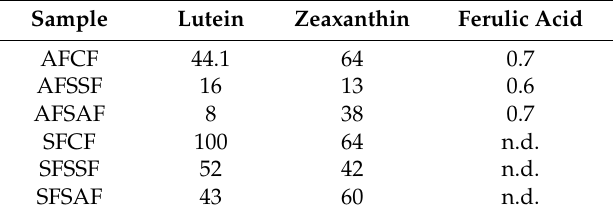
Table 3. Bioaccessibility (%) of lutein, zeaxanthin and ferulic acid in digested breads. Sample Lutein Zeaxanthin Ferulic Acid AFCF 44.1 0.7 AFSSF